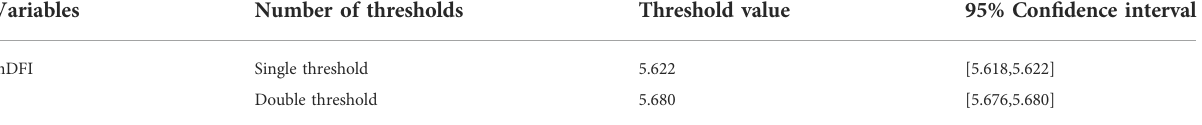
TABLE 9 Threshold estimation results.